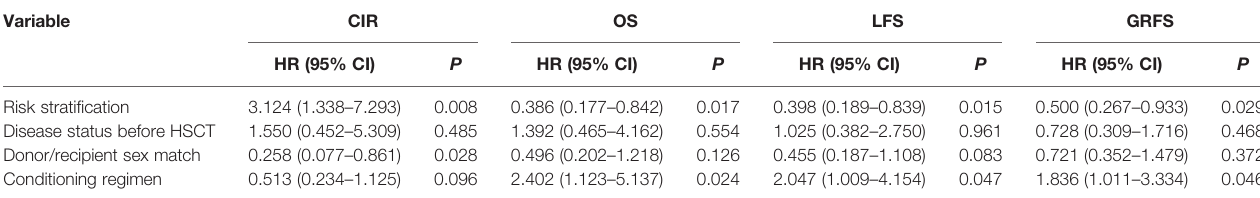
TABLE 5 | Multivariate analysis for relapse, OS, LFS, and GRFS. Variable